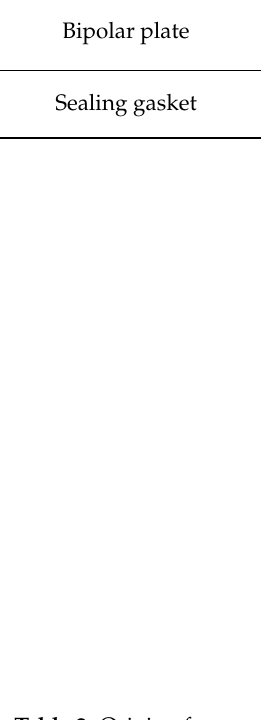
Table 2. Origin of common fuel and air impurities [2] (Reprinted with permission from Borup et al. [2]. Copyright (2007) American Chemical